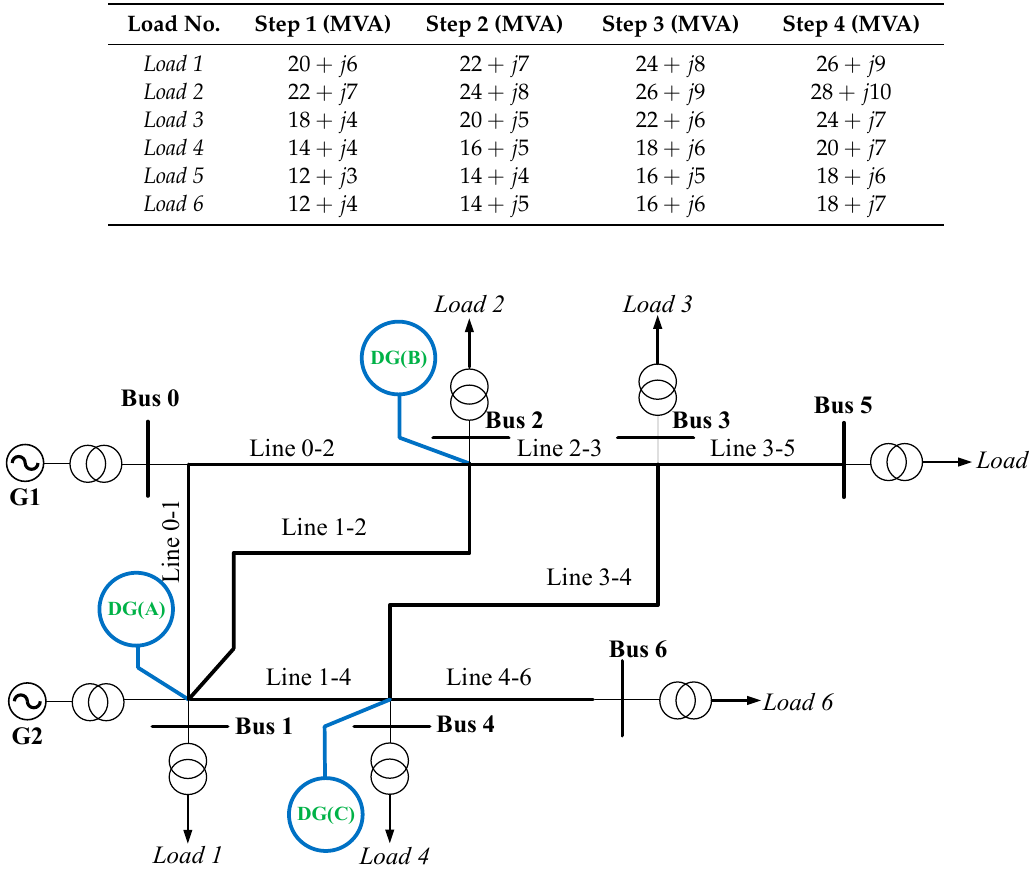
Figure 5. Proposed mesh grid.